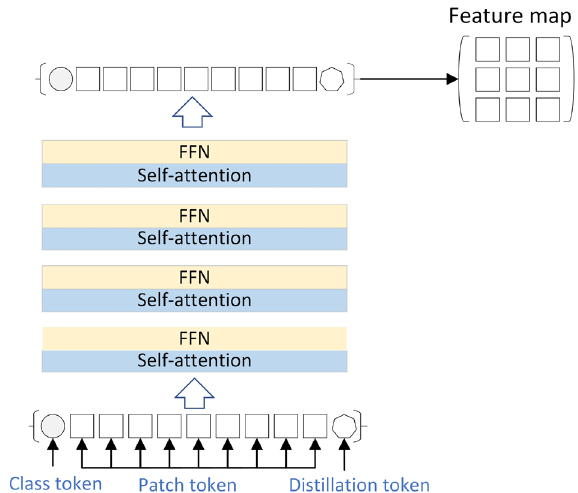
Fig. 2 The distillation procedure of the